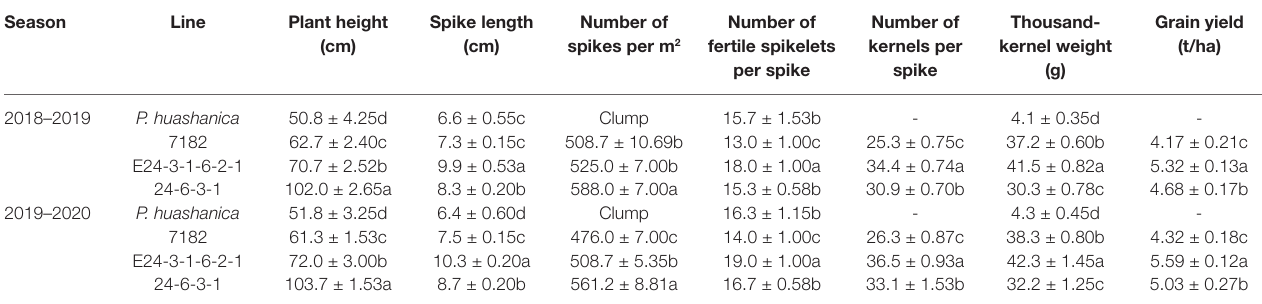
TABLE 1 | Agronomic performance of the wheat– P. huashanica translocation line E24-3-1-6-2-1, its parents, and addition line 24-6-3-1.